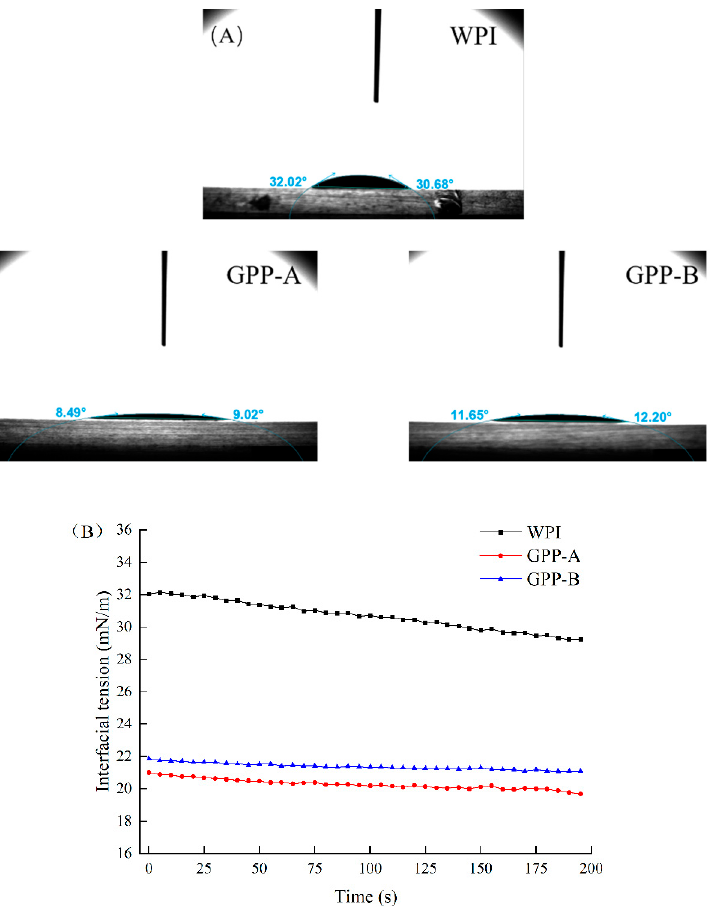
Figure 6. Changes in contact angle ( A ) and interfacial tension ( B ) of CLA emulsions stabilized by GPP-A and GPP-B.